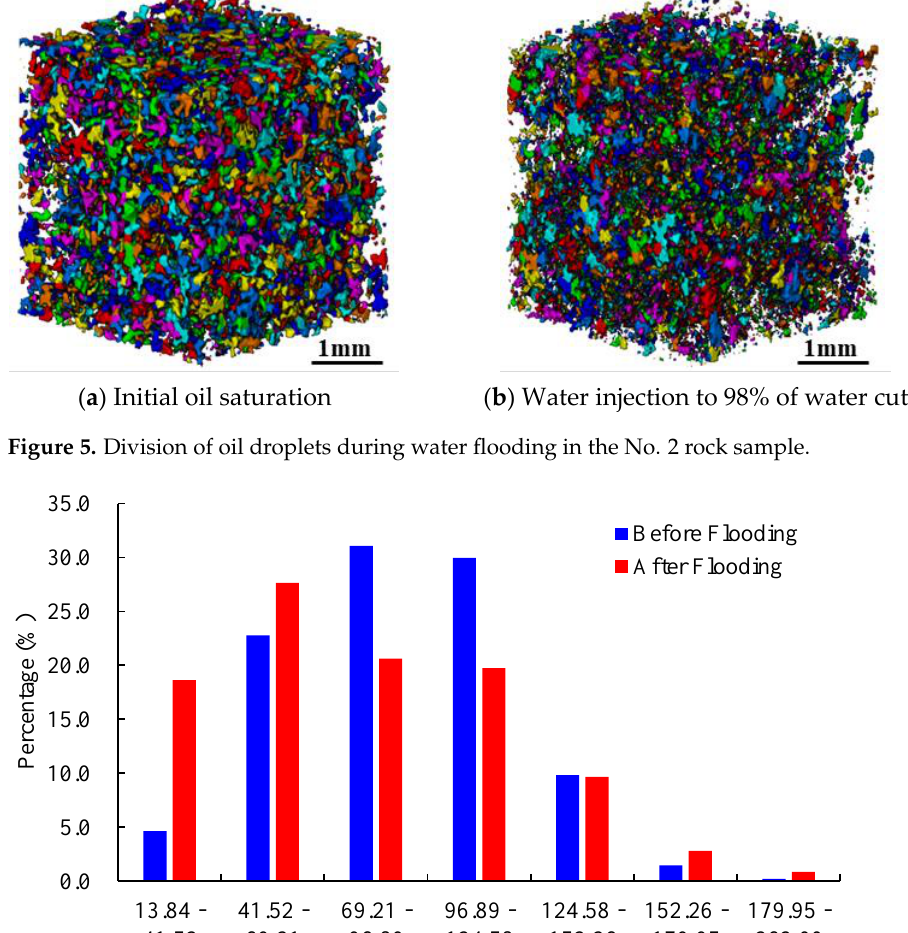
Figure 6. Frequency distribution of oil droplets during water flooding in No. 2 rock sample.